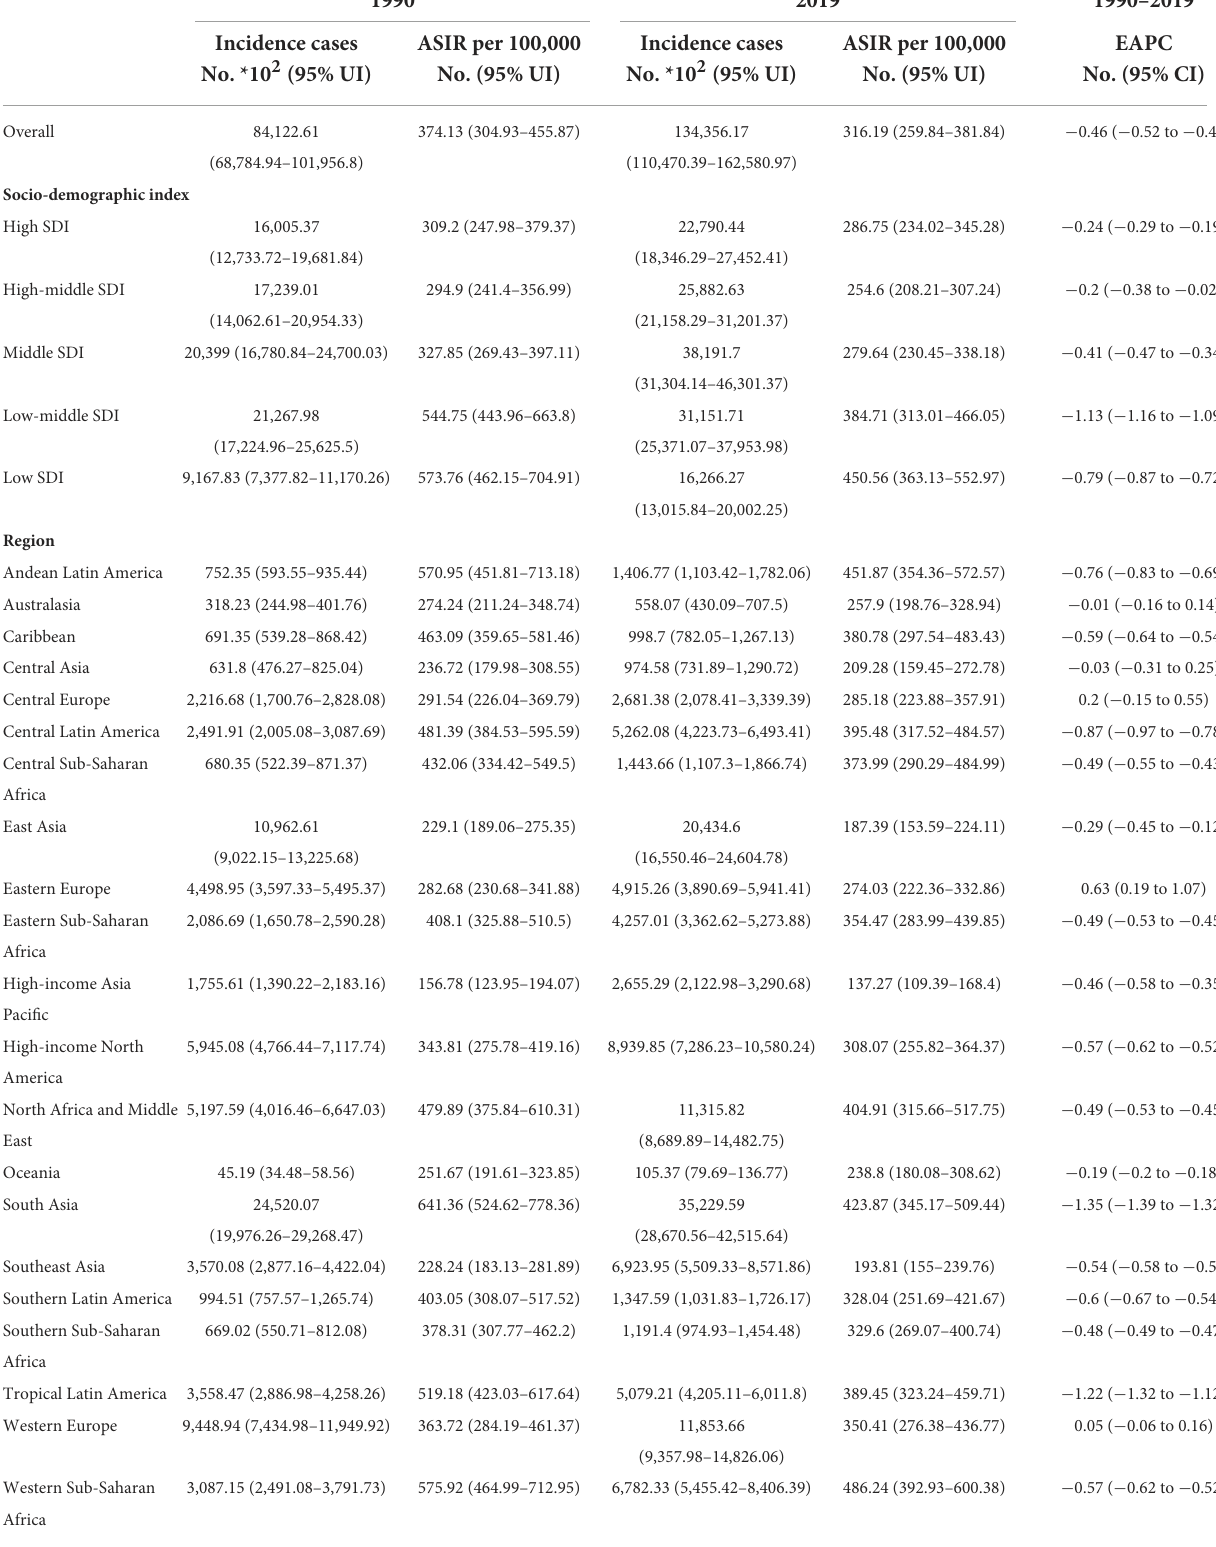
TABLE 1 Trends of incidence and age-standardized incidence rate of POP from 1990 to